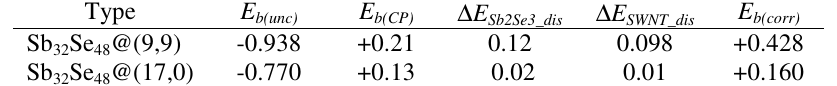
Se nanocrystals encapsulated in SWNTs 32 48